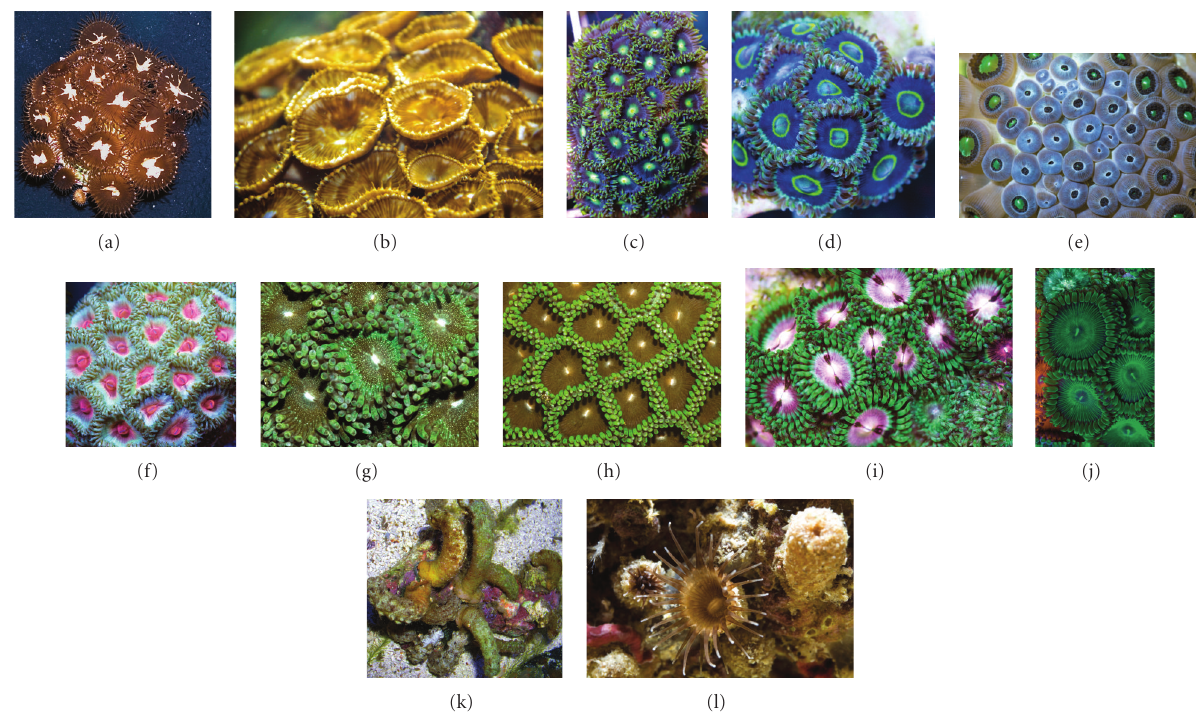
Figure 1: Zoanthid specimens from Florida examined in this study. (a) Palythoa a ff . variabilis 1558; (b) Palythoa grandis specimen 1559; (c) Zoanthus sociatus specimen 1579 and (d) specimen 1574; (e) Zoanthus a ff . pulchellus specimen 1575 and (f) specimen 1578; (g) Zoanthus pulchellus specimen 1572, (h) specimen 1576, and (i) specimen 1577; (j) Zoanthus solanderi specimen 1571; (k) Isaurus tuberculatus specimen 1580; (l) Terrazoanthus sp. specimen 1581. For collection details refer to Table